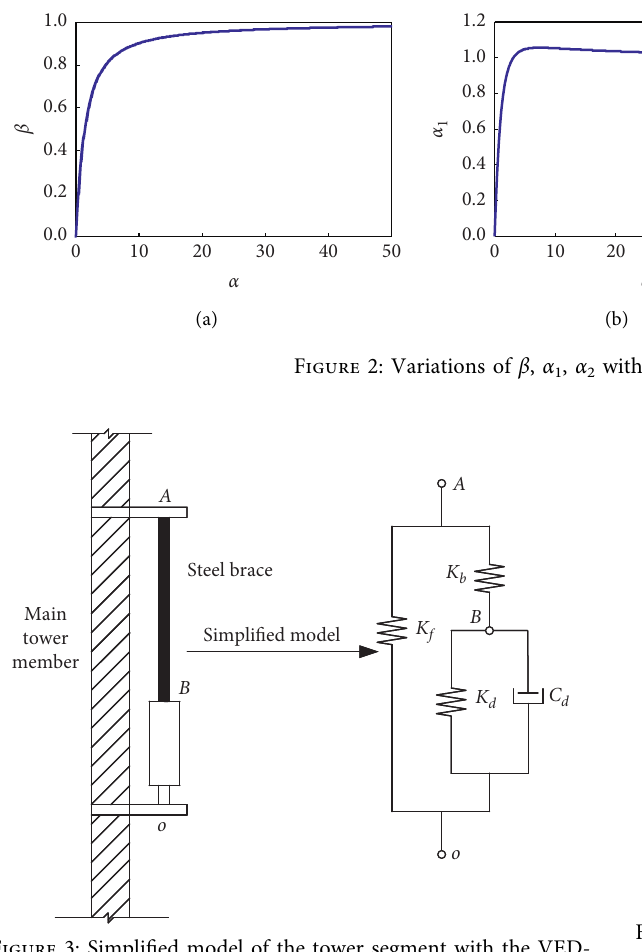
Figure 3: Simplified model of the tower segment with the VED- brace system.